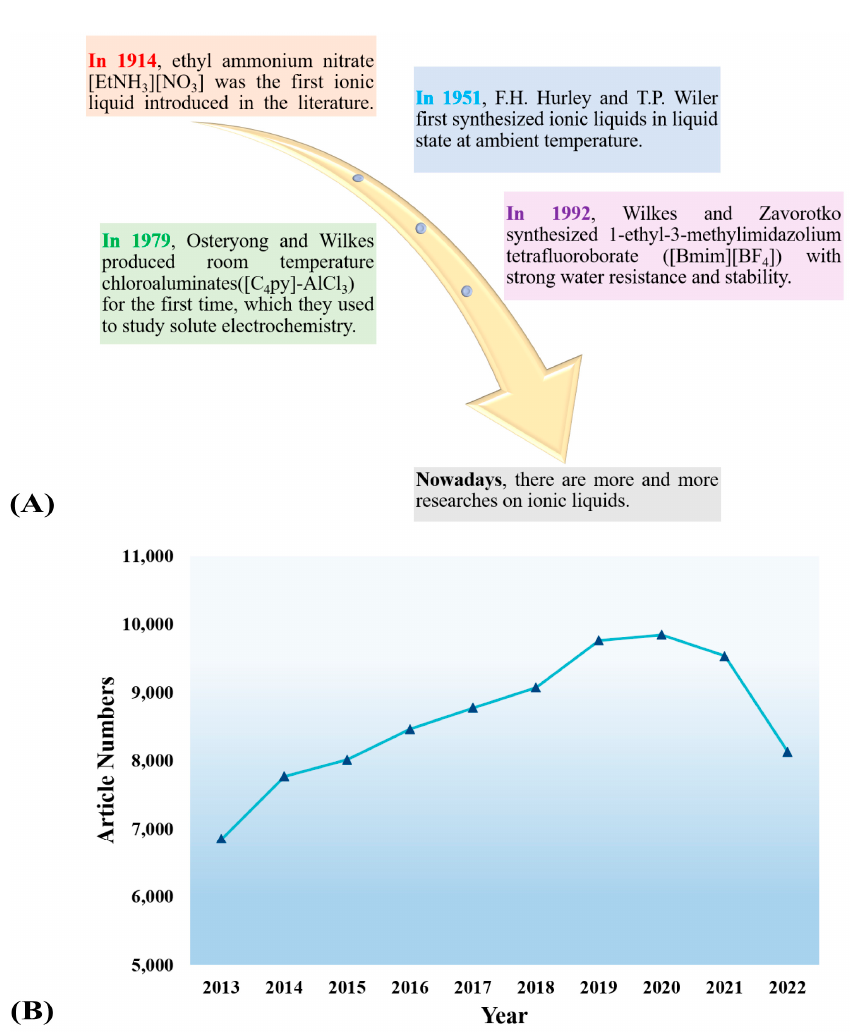
Figure 1. ( A ) Development history of ionic liquids. ( B ) Trends in the amount of academic documents on ionic liquids published from 2013 to 2022 (data based on Web of Science search, using the keyword “ionic liquids”).